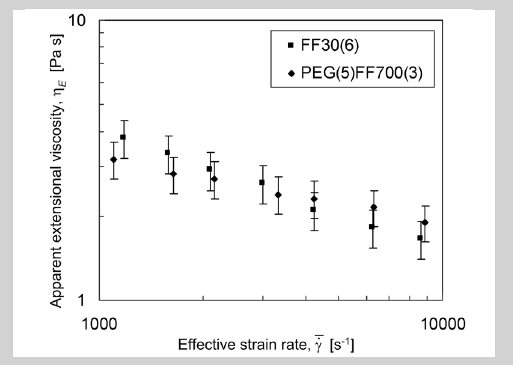
Figure 7 (left): Apparent extensional viscosity as a function of effective strain rate for non-pigmented fluids. Figure 8 (right): Apparent extensional viscosity as a function of effective strain rate for all the coating